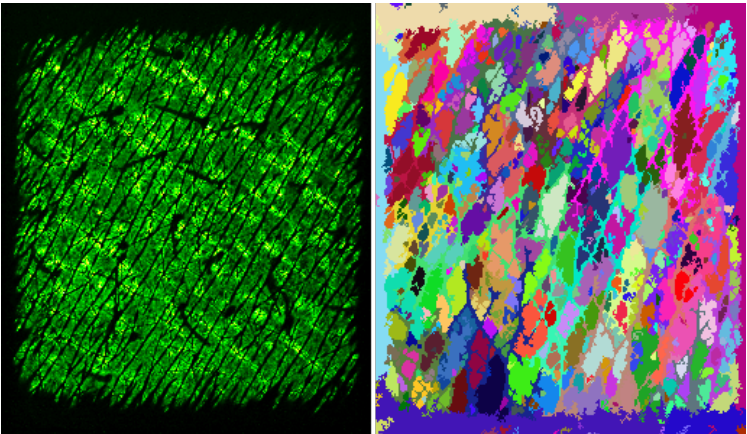
Figure 4. Example application of graph-based segmentation algorithm on capacitive image from volar wrist area. Left the original and right the segmented frame. For this demonstration, algorithm developed by Felzenszwalb and Huttenlocher is used [31].